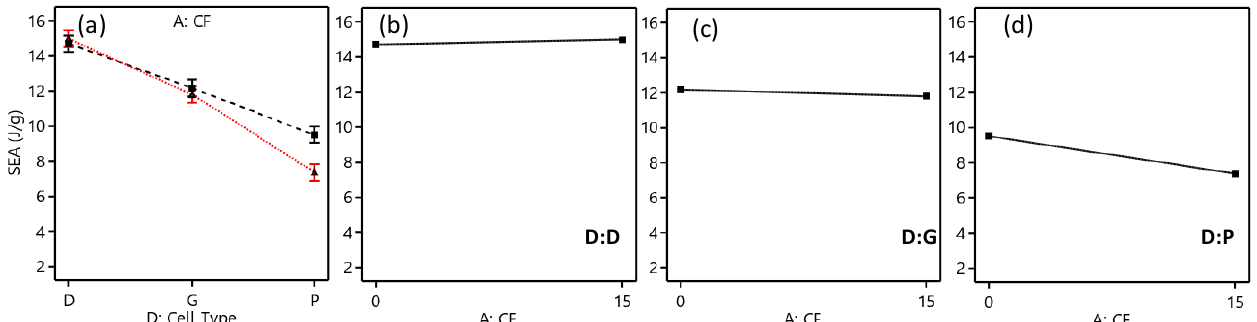
Figure 13. Influence of the main factors on the SEA.